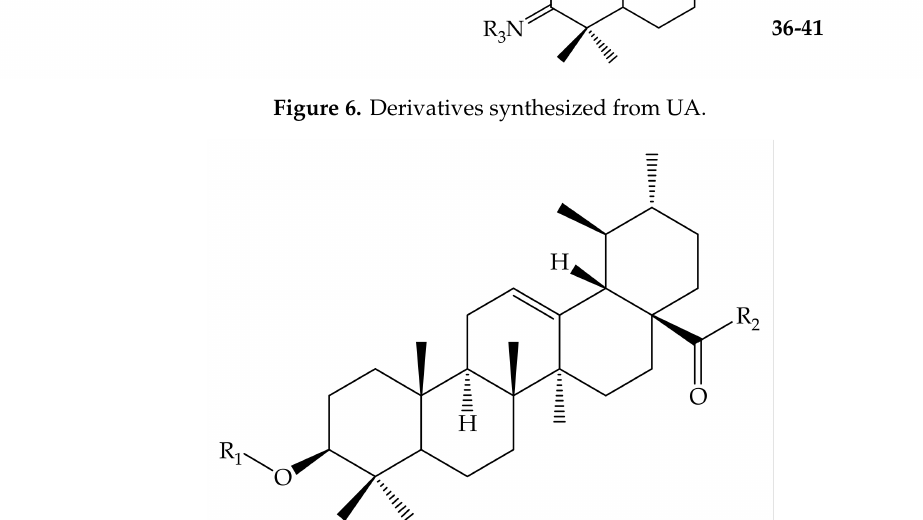
Figure 7. Synthesized UA derivatives. 42–46; 42: R 1 = COCH 3 ; R 2 = OH; 43: R 1 = COCH 2 CH 3 ; R 2 = OH; 44: R 1 = COCH 2 CH 2 CH 3 ; R 2 = OH; 5: R 1 = H; R 2 = OCH 3 ; 46: R 1 = H; R 2 = NHCH 2 CH 2 CH 3